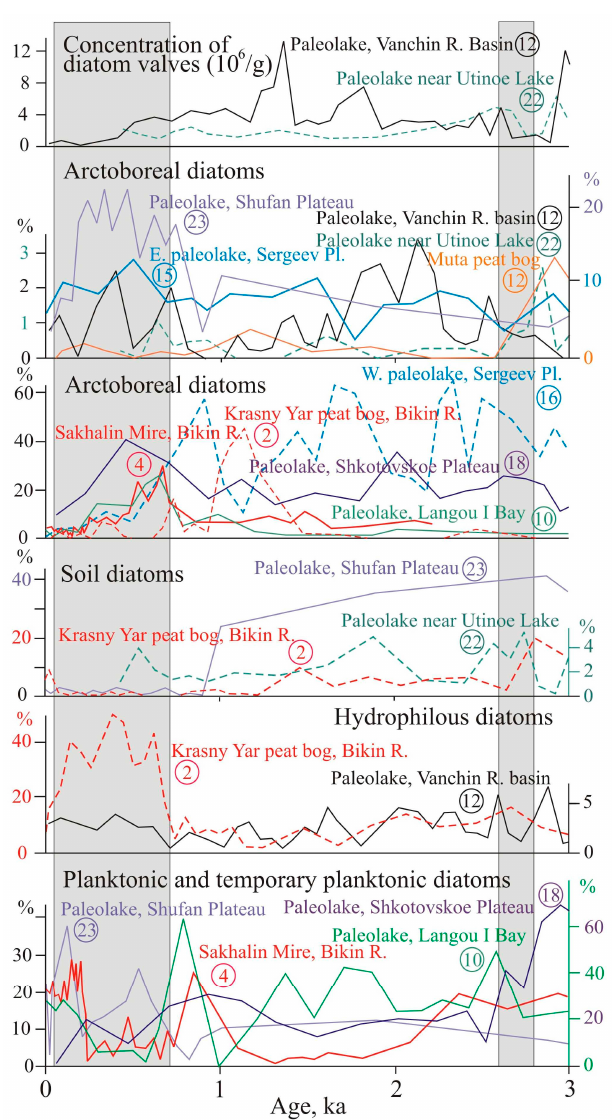
Figure 3. Comparison of results for diatom proxies from peat bog and paleolake sequences on the mainland. Grey bars indicate 2800–2600 year BP cold event and the LIA. Number of sites according to Figure 2.